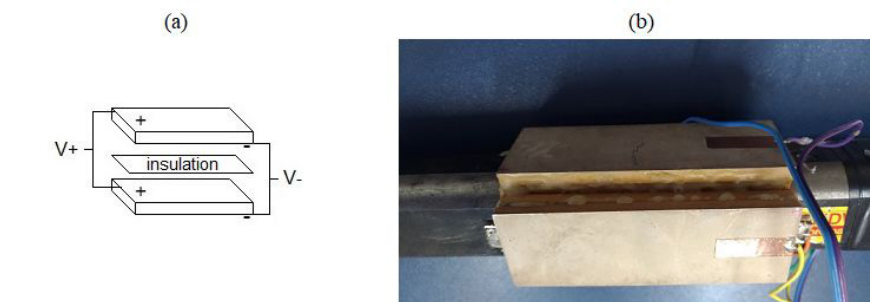
Figure 3. Assembly of multilayer piezoelectric actuator in parallel a) diagram; b) assembly with adhesive and silicon isolation layer.